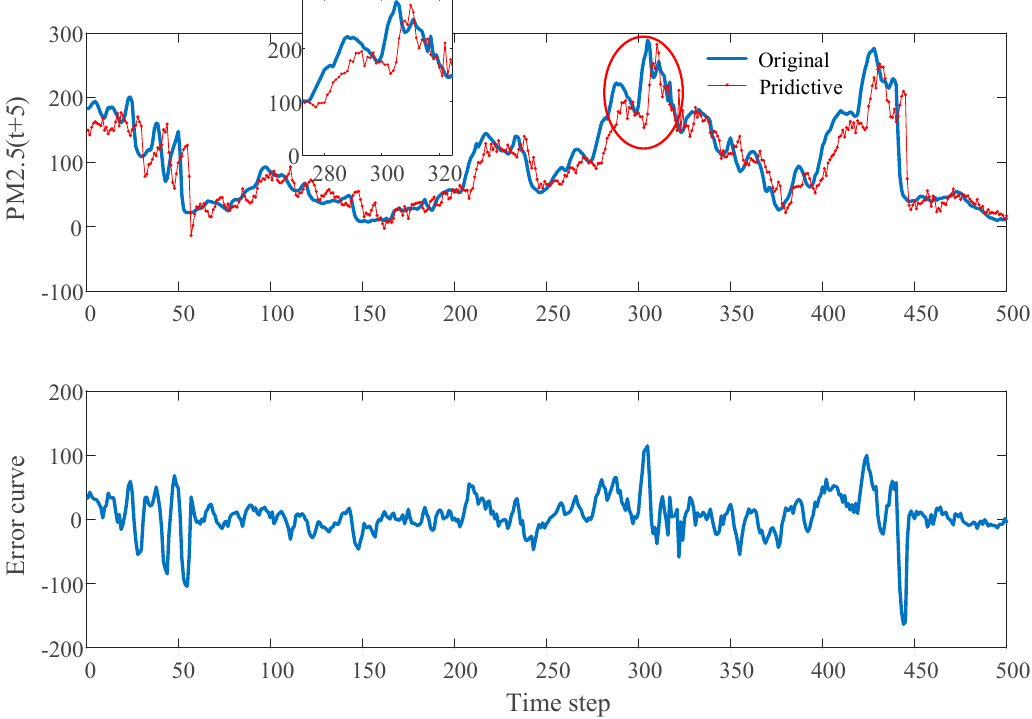
Figure 7. PM 2.5 concentration five-step (5 hours) prediction curve. Table 4. Comparison of ten-step (10 hours) prediction results.